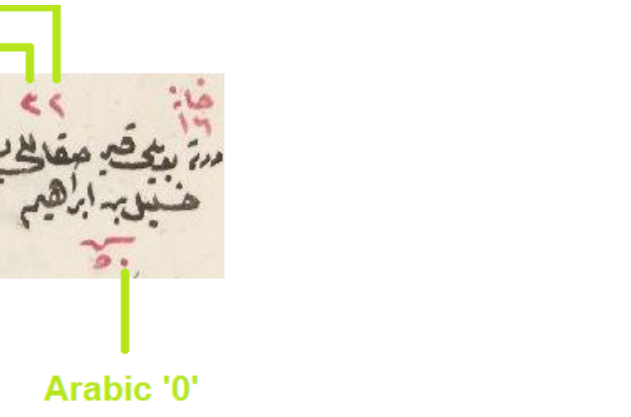
Figure 8. Arabic numbers 0, 2, and 3 from the population registers are shown. It could be seen that 2 and 3 are very similar and 0 is hard to detect. Table 2. The comparison of machine learning algorithms in both recognition performance in the test set of our public dataset and the performances of the trained and saved models for correctly recognizing digits in the case study.